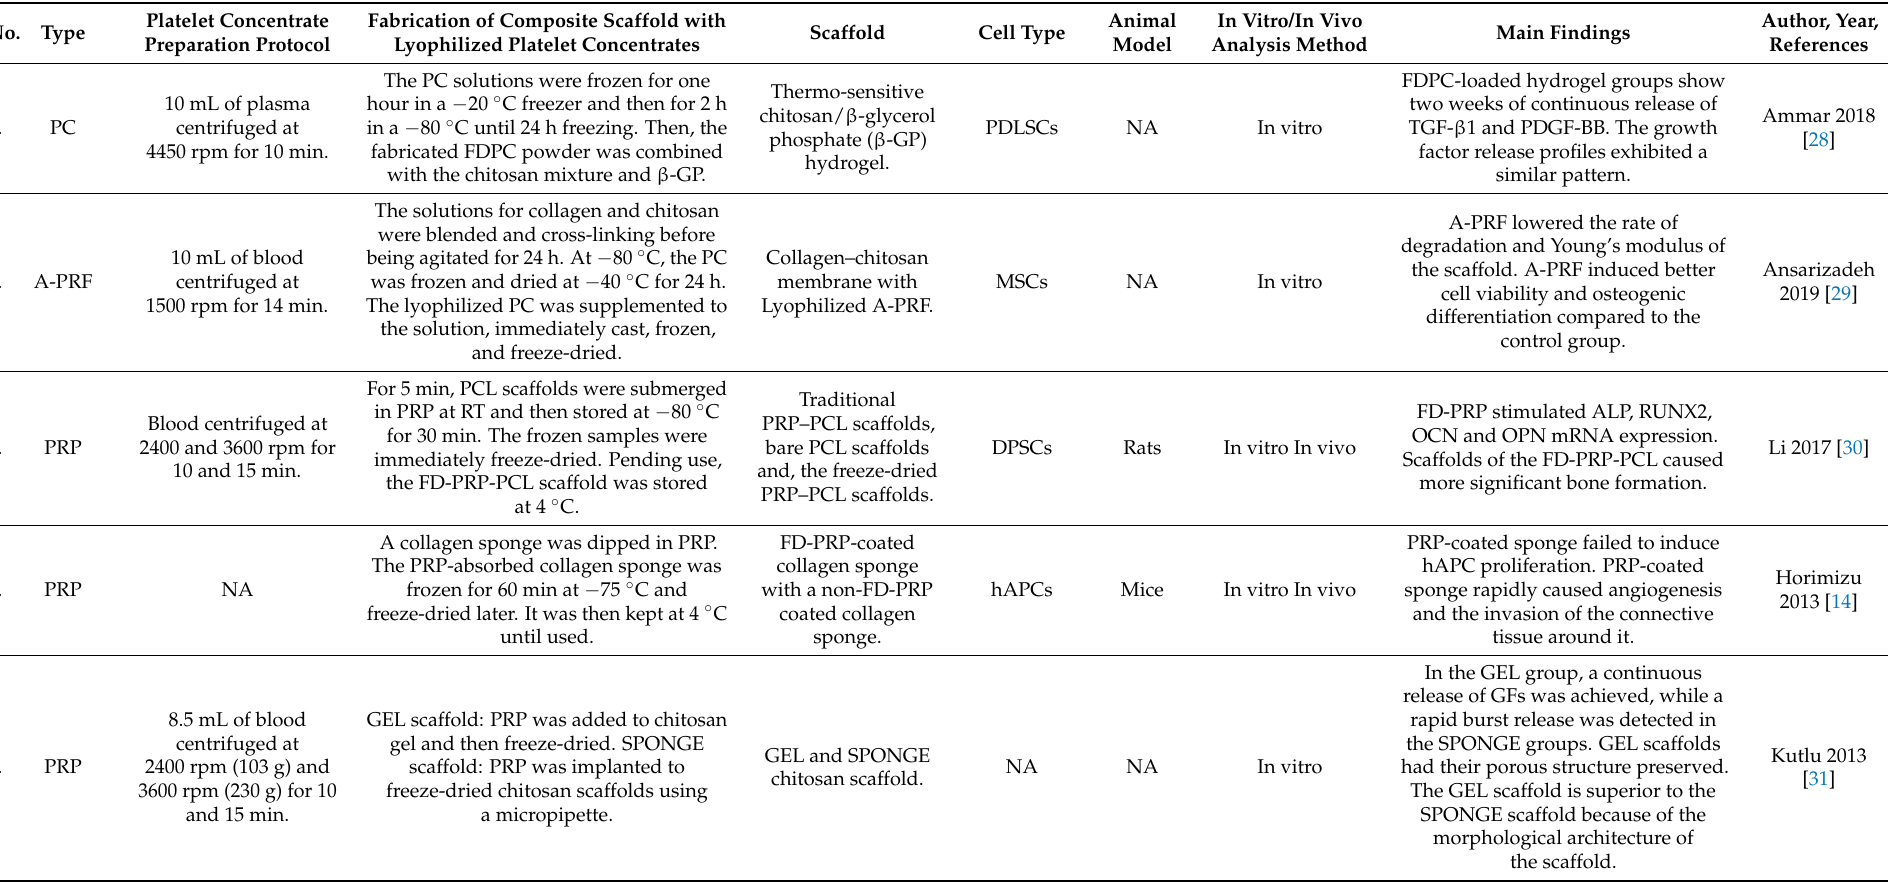
Table 1. Different preparation methods of lyophilized platelet concentrates as craniofacial bioactive